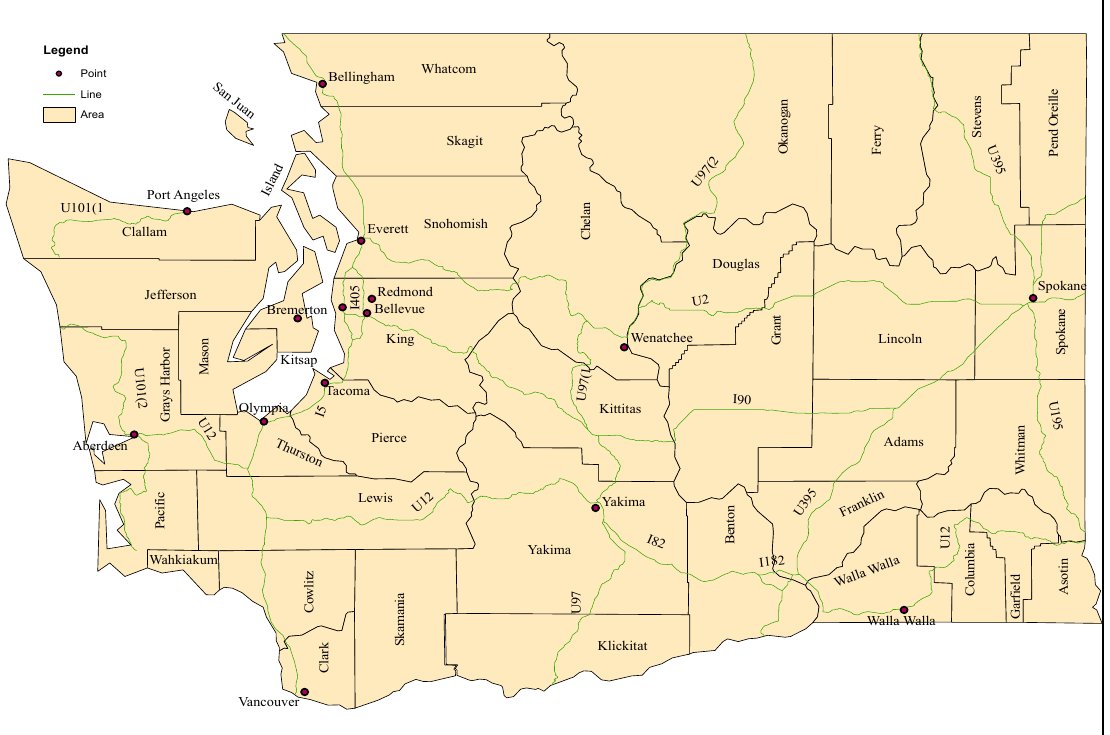
Figure 9. Result of the first dataset using the proposed algorithm.